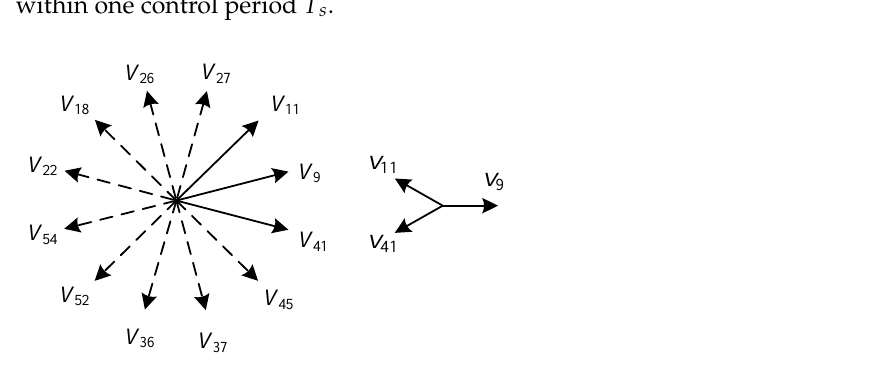
Figure 11. The mappings of vectors V 41 , V 9 , and V 11 onto the harmonic subspace are v 41 , v 9 , and v 11 , respectively. v 11 leads v 9 by 150 ◦ , and v 41 lags v 9 by 150 ◦ . The components of